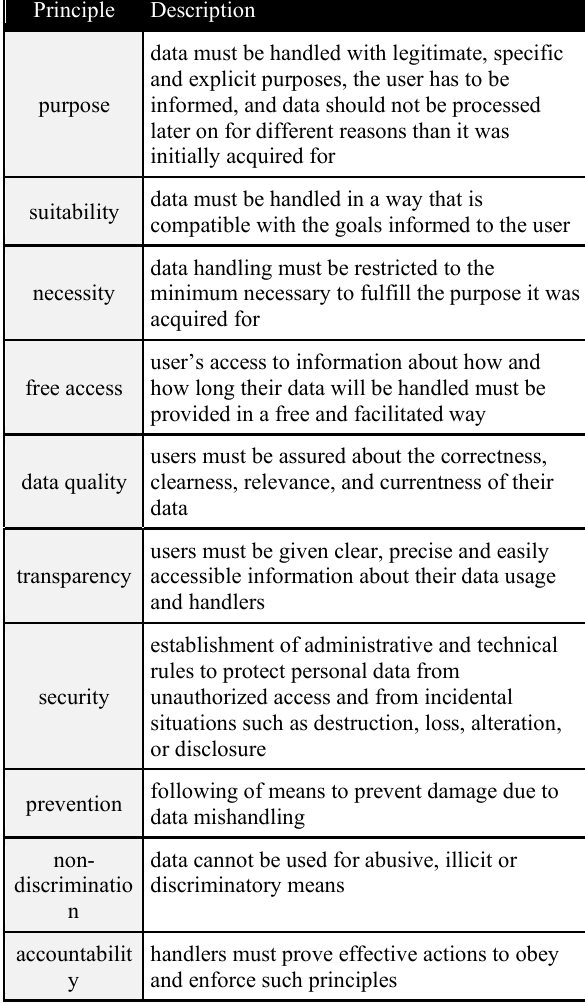
Figure 7. Principles that must be obeyed on personal data handling (source: Brazilian law